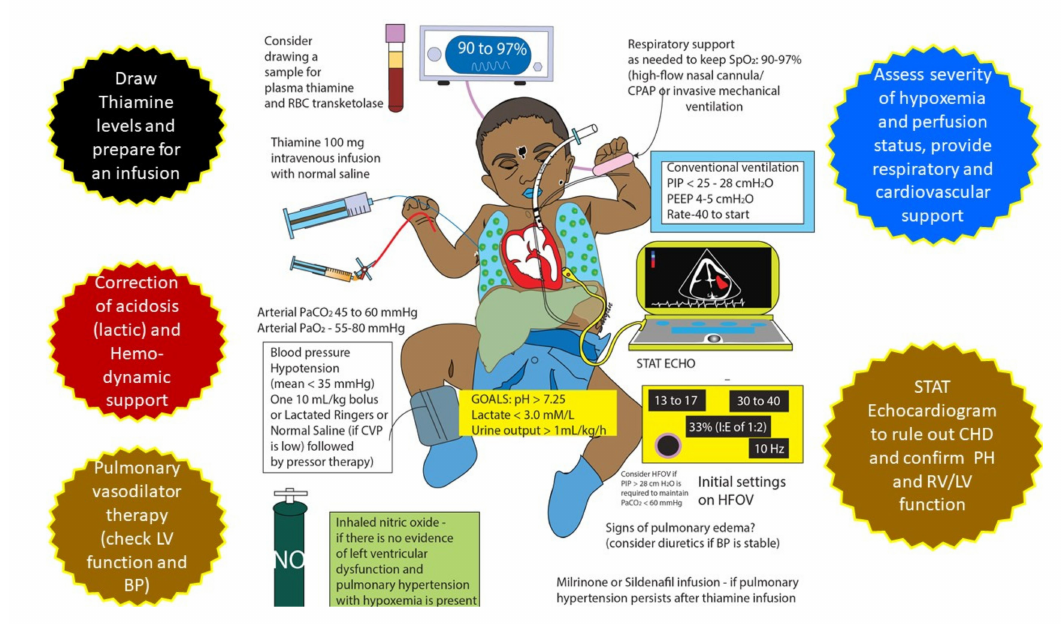
Figure 5. Treatment protocol for TRAPHEI (copyright Satyan